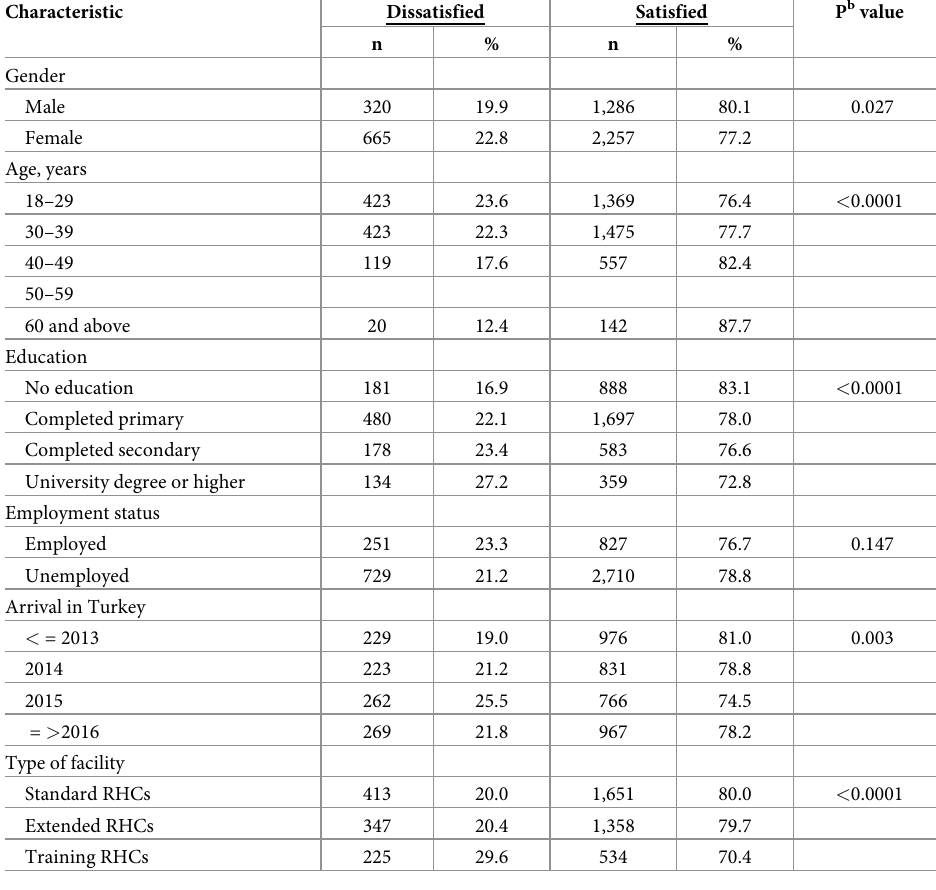
b Pearson’s chi-squared